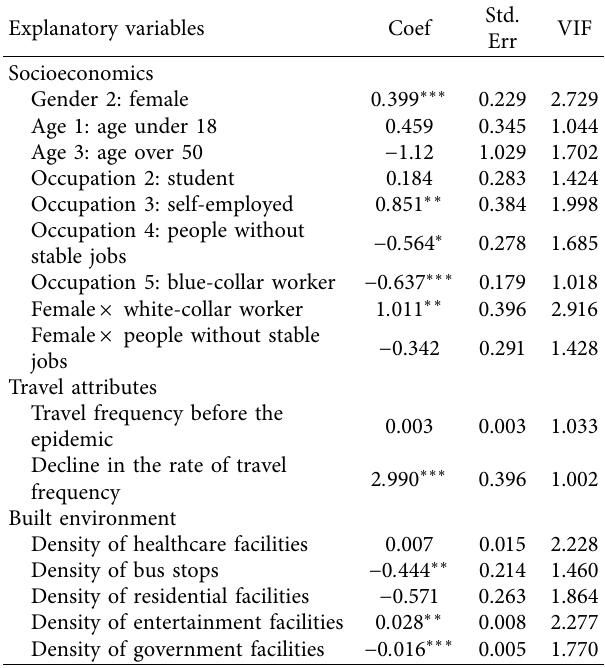
Table 2: Estimation results of determinants of travel mode